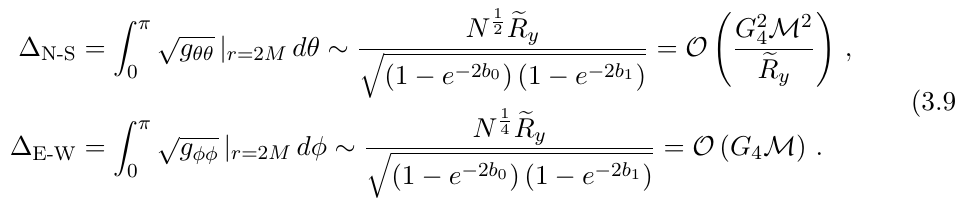
Figure 5. Sizes of the φ , y 1 and y 2 circles on the z -axis for N = 20 and e R y written illustrative values on the horizontal axis that are obtained by computing the values at the middle bubbles while taking the large N